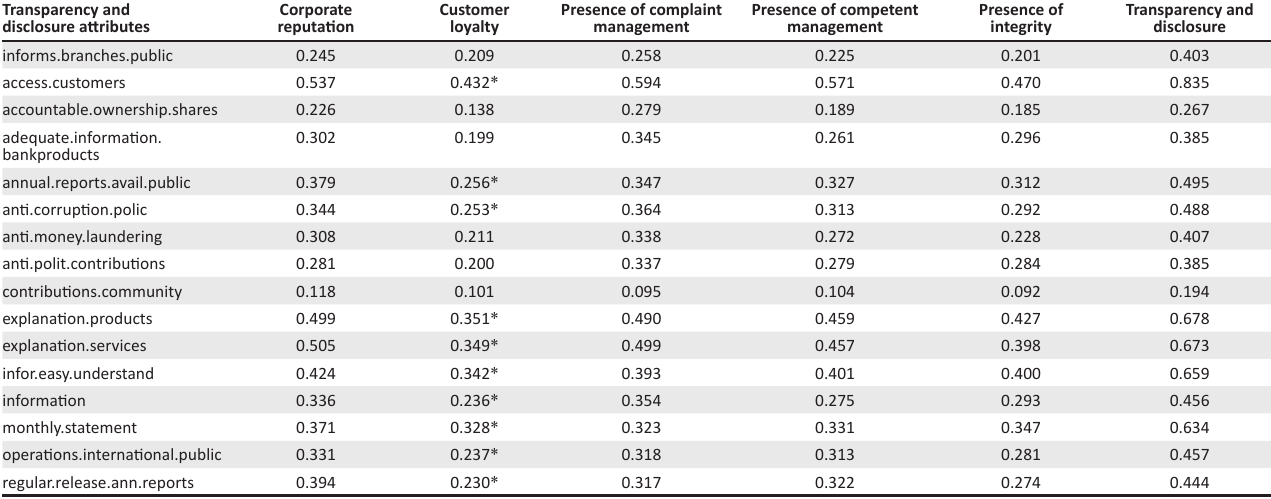
TABLE 5: Cross-loadings (correlations) of transparency and disclosure attributes on customer loyalty. Transparency and disclosure attributes